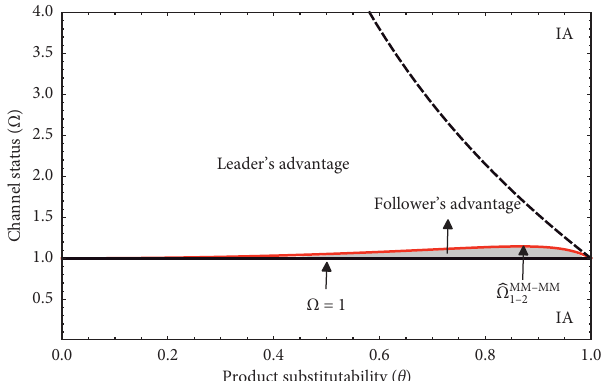
Figure 8: Comparison between channel 1 and channel 2 profits under MM.